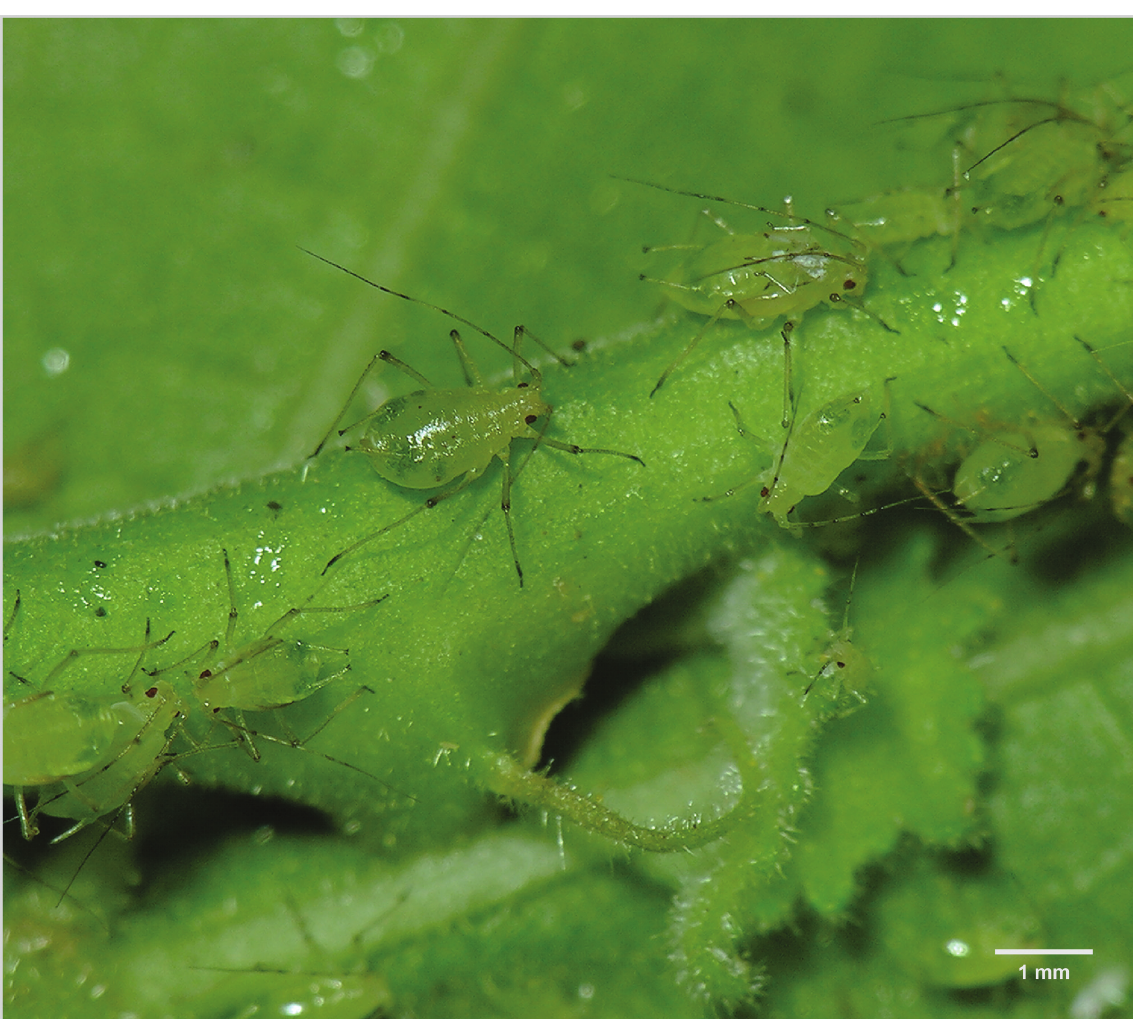
Fig. 28. Aulacorthum solani (Kaltenbach, 1843). Apterae and juveniles on Abutilon sp.